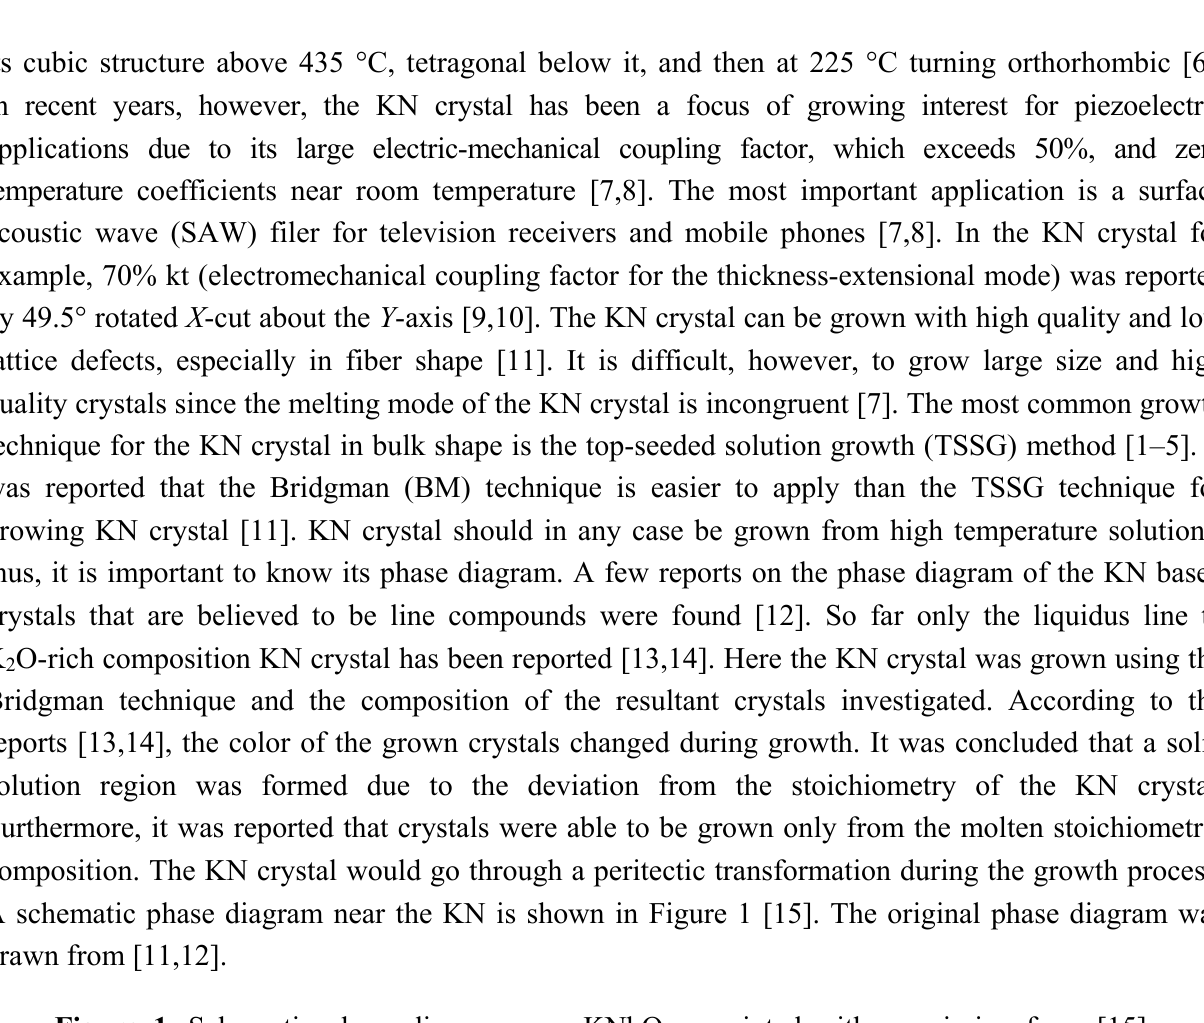
Figure 1. Schematic phase diagram near KNbO